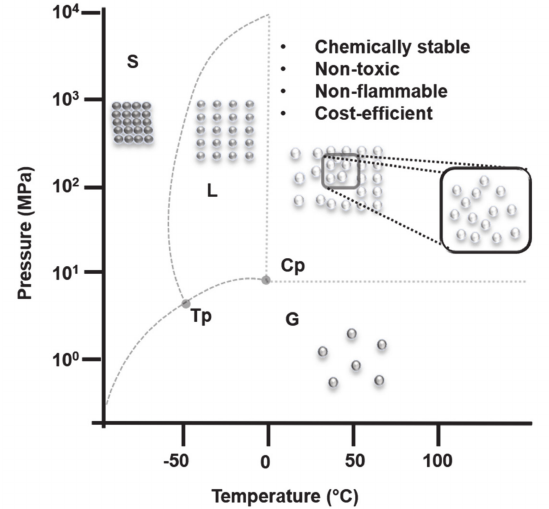
Figure 1. Phase diagram of carbon dioxide (CO 2 ) (not to scale). S, L, and G denote the solid, liquid and gaseous phases respectively. Cp denotes the critical pressure point (31 ◦ C, 7.3 Mpa) and Tp denotes the triple point ( − 56 ◦ C, 0.5 MPa) for CO 2